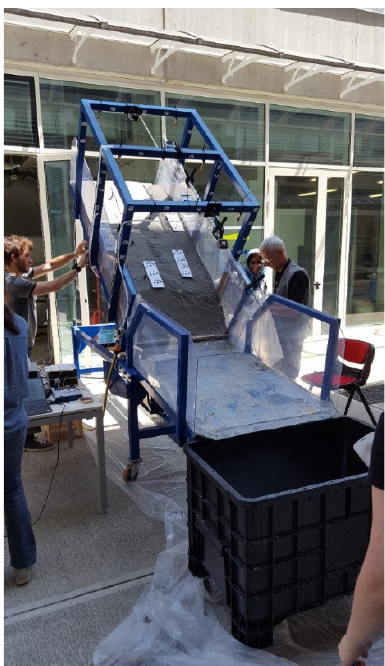
Figure 1. The landslide simulation facility set up on Lecco Campus of Politecnico di Milano,